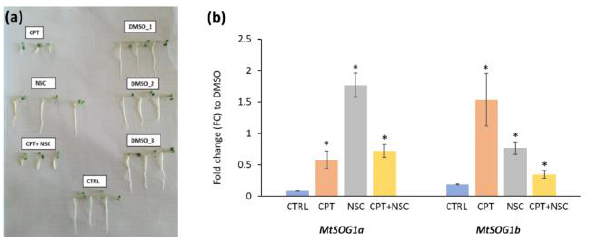
Figure 7. ( a ) Representative image of 7-day-old M. truncatula seedlings to evaluate the phenotypic effect of CPT, NSC, and CPT+NSC treatments and corresponding DMSO concentrations (DMSO_1, DMSO_2, DMSO_3). Control (CTRL), non-treated seedlings are also included. ( b ) Expression profiles of MtSOG1a and MtSOG1b in response to the imposed treatments. Data are represented as fold- change (FC) to the respective DMSO controls. Statistically significant ( p < 0.05) differences between treatments and control (CTRL, un-treated seedlings) are represented with an asterisk (*).